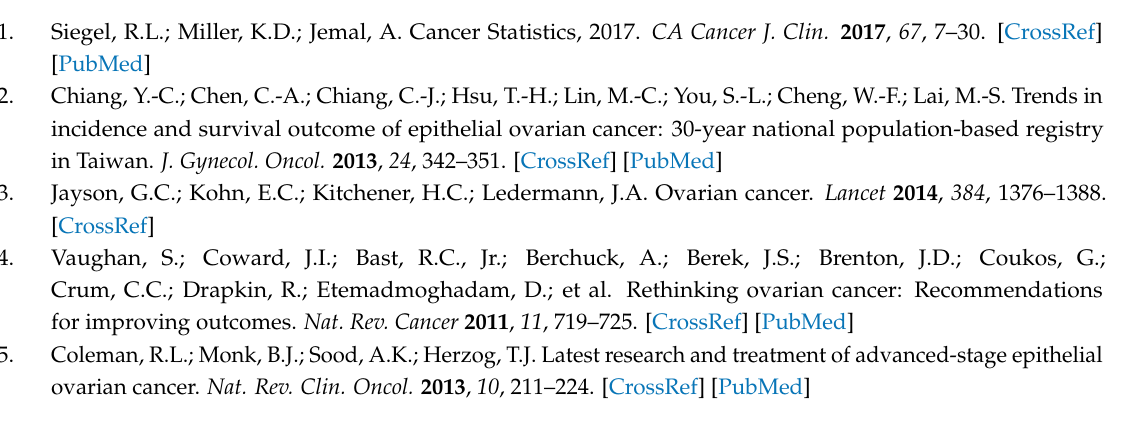
Figure S1: The proposed genetic algorithm (GA) to identify the best combinations of predictors for the SVM model, Figure S2: The Kaplan Meier survival curves of the RFS in the three response groups in the (A) TCGA, (B) GSE9891 and (C) NTUH datasets, Figure S3: The Kaplan Meier survival curves of the OS in the three response groups in the (A) TCGA, (B) GSE9891 and (C) NTUH datasets, Figure S4: The gene-gene interaction network of the 10 genes analyzed using the Ingenuity Pathway Analysis website, Table S1: The quantitative PCR primers of TaqMan probes, Table S2: Distribution of OS and RFS in the patients classified into three groups, Table S3: Characteristics of the three microarray datasets, Table S4: The 25 ovarian cancer lines in GSE36133 utilized as the training